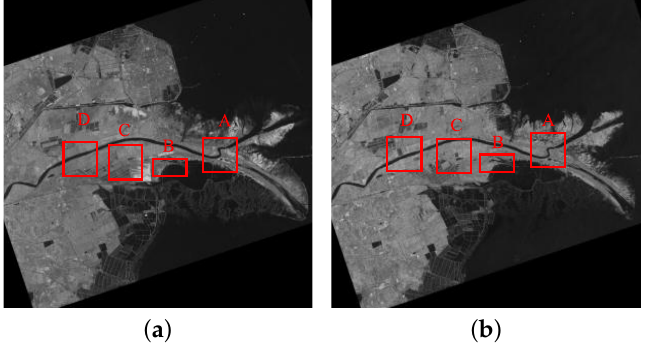
Figure 8. Multitemporal image relating to the Yellow River data set. ( a ) Image acquired in June 2008. ( b ) Image acquired in June 2009.Area A: Inland Water; Area B: Costaline; Area C: Farmland C; Area D: Farmland D.